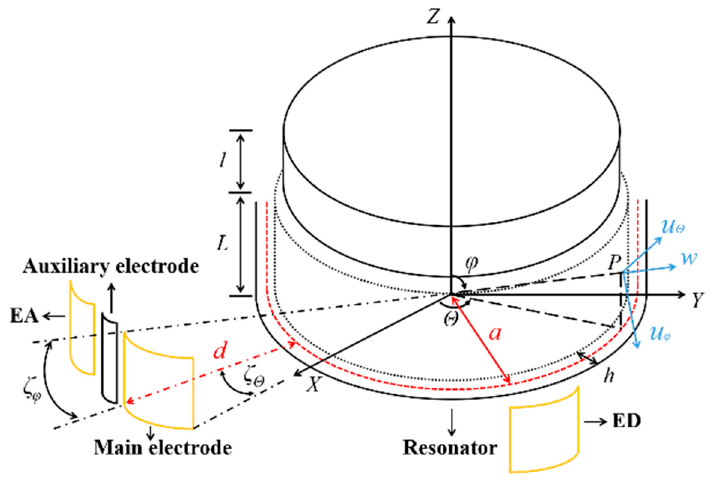
Figure 1. Schematic diagram of the resonator coordinate.